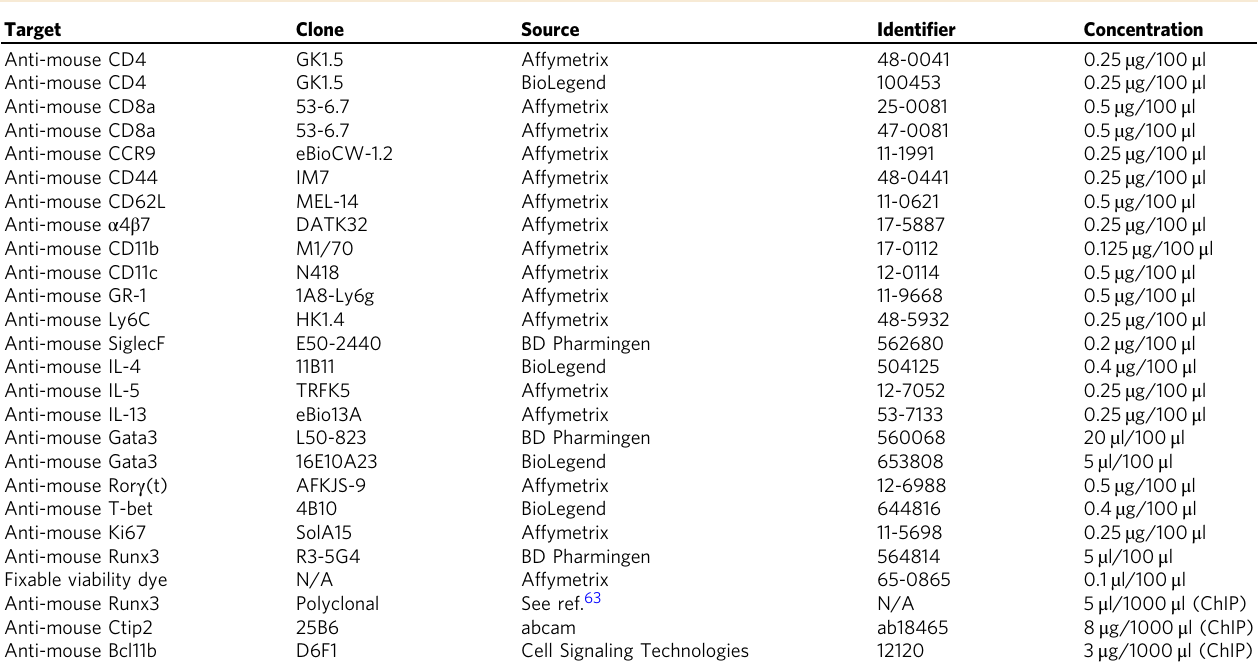
Table 1 Antibodies used in this